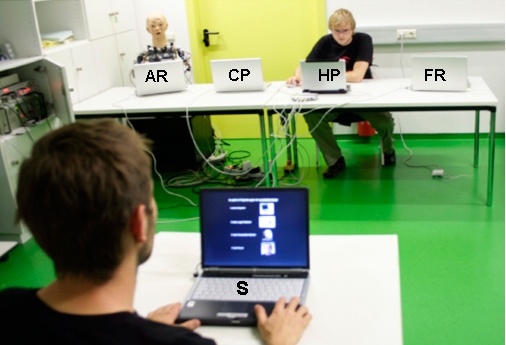
Arrangement of the briefing; from left to right in the back: anthropomorphic robot (AR), computer partner (CP), human partner (HP) and functional robot (FR); in front: subject (S).